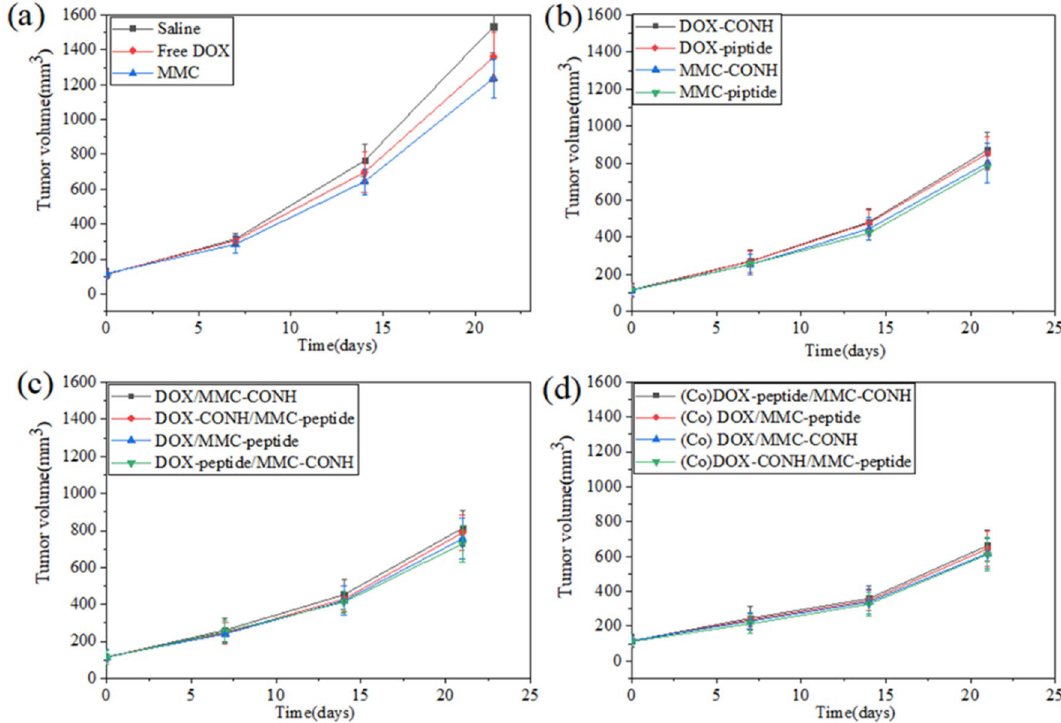
Figure 7. ( a ) In vivo therapeutic efficacy of Saline, free DOX, free MMC ( b ) In vivo therapeutic efficacy of DOX/MMC-CONH, DOX-CONH/MMC-peptide, DOX/MMC-peptide, DOX-peptide/MMC-CONH ( c ) In vivo therapeutic efficacy of (Co) DOX-peptide/MMC-CONH, (Co) DOX/MMC-peptide, (Co) DOX/MMC- CONH, (Co) DOX-CONH/MMC-peptide ( d ) In vivo therapeutic efficacy of DOX-CONH, DOX-peptide, MMC-CONH, MMC-peptide. Tumor size changes of the xenograft nude mice bearing the DOX resistant HepG2 tumors treated with different polymer-drug conjugate formulations. After establishment of HepG2/DR tumor model for 3 weeks into BALB/c nude mice, these DOX resistant HepG2 tumor-bearing mice were treated with drugs (25 μmol/kg) by tail vein injection every week for four doses (days 1, 7, 14, and 21). Data were given as mean ± SD (** p <